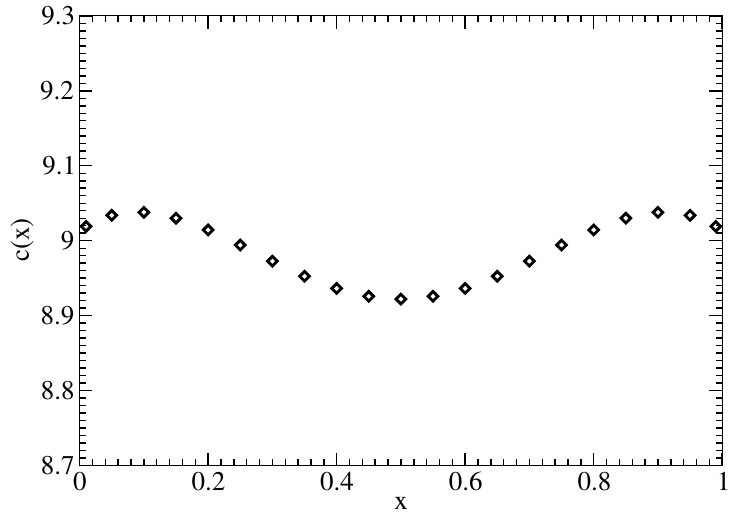
Figure 20 . Extraction via (4.13) of the x -dependence of the \constant" c in the form (4.12) for (cid:22) s ( x